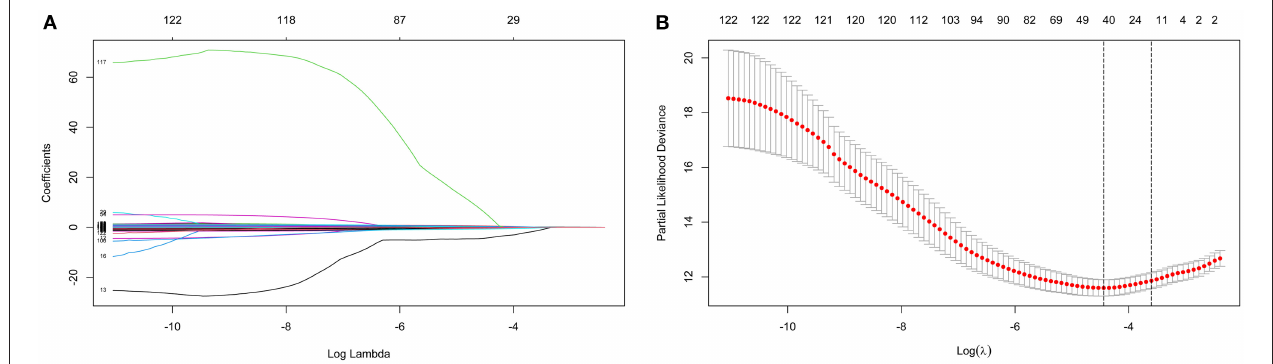
FIGURE 2 | Identification of variables using the least absolute shrinkage and selection operator (LASSO) regression algorithm. The numbers above the graph represent the number of variables involved in the LASSO model. (A) LASSO coefficient profiles of the 122 variables. (B) Identification of the optimal penalization coefficient λ in the LASSO model. The partial likelihood deviance is plotted against log ( λ ), where λ is the tuning parameter. Red dots indicate average deviance values for each model with a given λ , and partial likelihood deviance values are shown, with error bars representing s.e. The dotted vertical lines are plotted at the value selected using the 10-fold cross-validation and 1 – s.e.